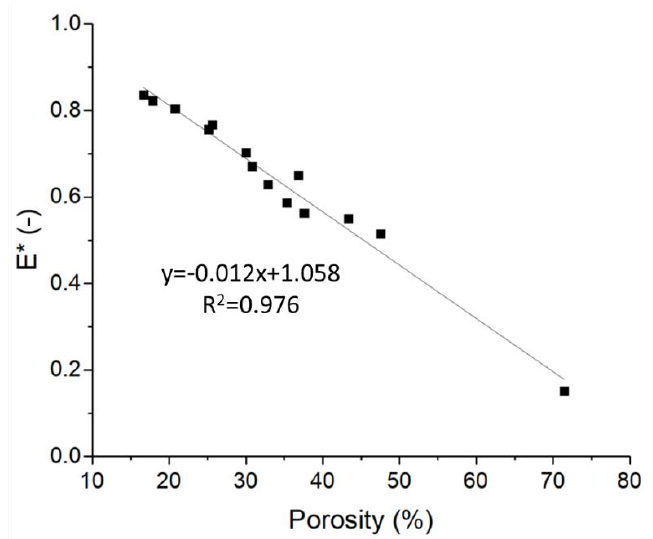
Figure 7. Values of the relative Young’s modulus with respect to the sample porosity. An inverse linear dependence on porosity can be observed, regardless of the sample wall thickness and cell size.